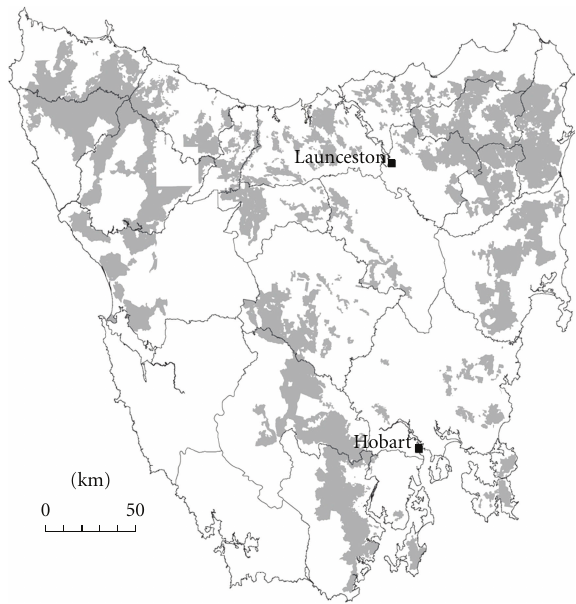
Figure 1: Tasmanian State forest and Inventory Management Areas. Shaded regions indicate land managed by Forestry Tasmania, excluding 1242ha located on King Island, lines delineate the State into Inventory Management Areas.